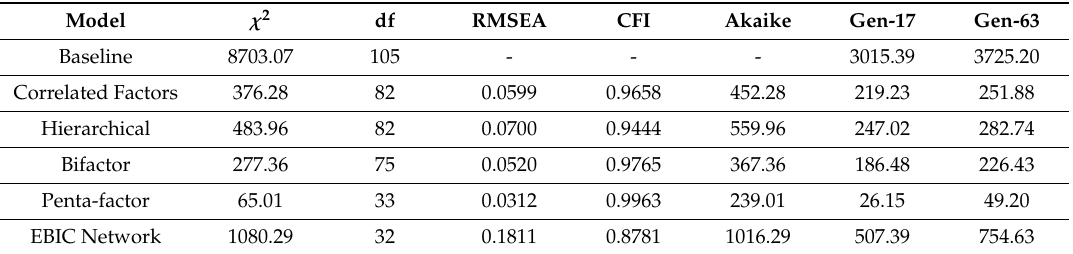
Table2. SummaryoffitindicesformodelsevaluatingWAIS-IVUncorrectedCorrelations. Abbreviations are the same as in Table